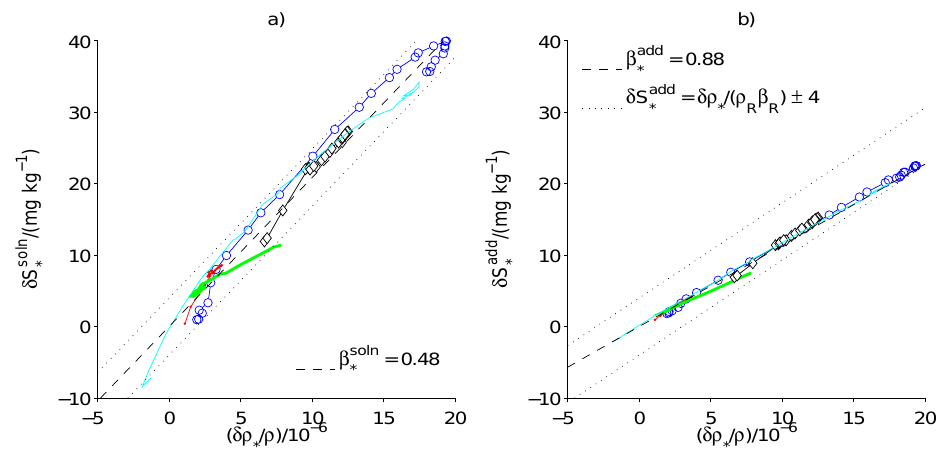
Fig. 10. Calculated salinity/density relationships for example profiles. Legend as for Figs. 5 and 7. (a) δS soln ∗ /δρ ∗ relationship. (b) δS add ∗ /δρ ∗ relationship. Dotted lines show salinity uncertainty of ± 4mg kg − 1 above and below the